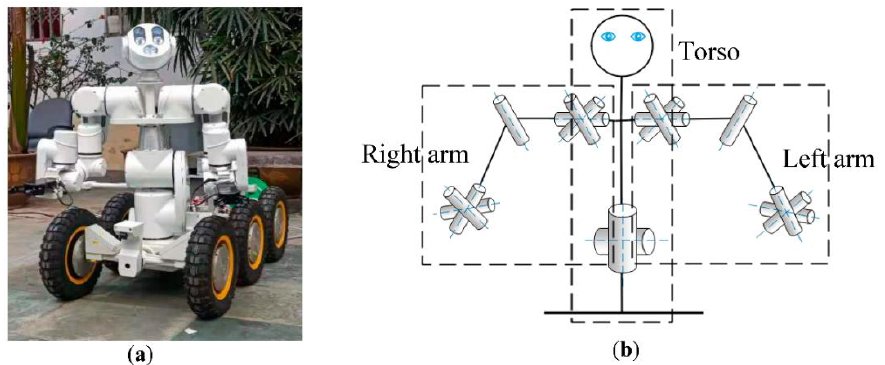
Figure 1. ( a ) Humanoid dual-arm robot. ( b ) Structure of the robot with 16 degrees of freedom. The robot was divided into three parts: torso, left arm, and right arm.